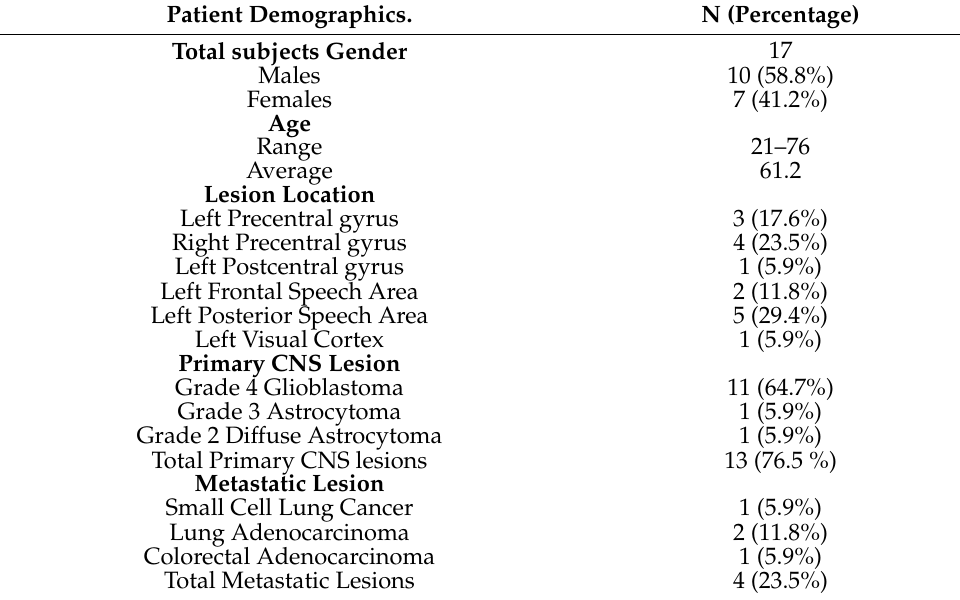
Table 2. Patient demographical data and tumor characteristics. Patient